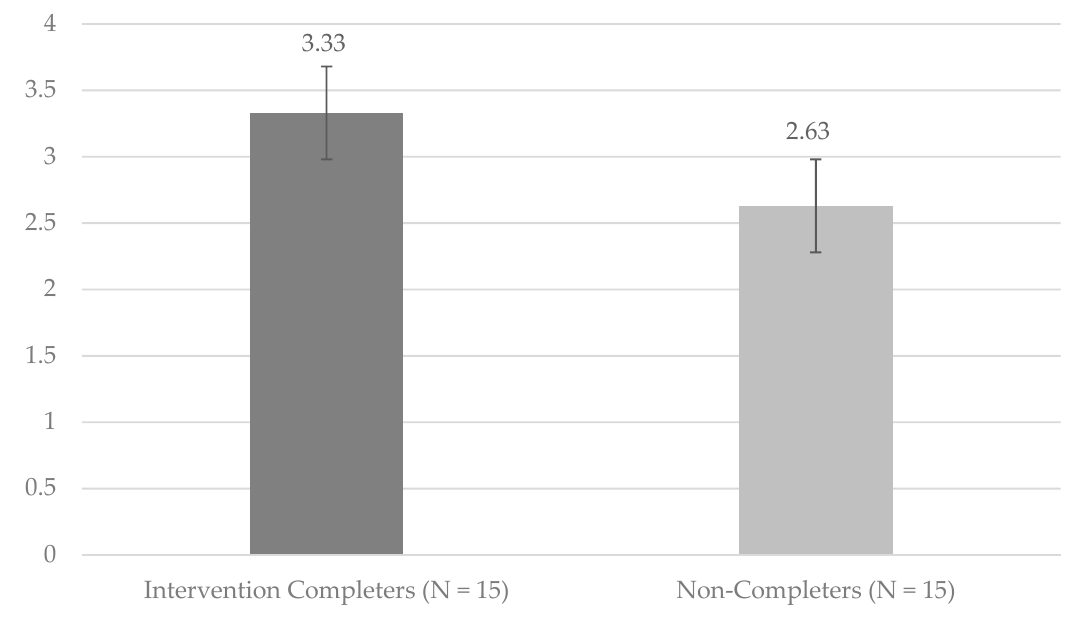
Figure 2. Baseline means and standard errors for perceptions of internal locus of control. Among Intervention Completers only, bivariate correlations were run between the SPPA PA and MHLC Internal subscales with change scores in OBEs and emotional eating (based on the EES) from baseline to post-intervention. Higher internal HRLOC and more positive perceptions of appearance at baseline were both associated with greater reduc- tion in OBEs and emotional eating. Mean scores and correlations are presented in Table 1. Table 1. Bivariate correlations among Intervention Completers.